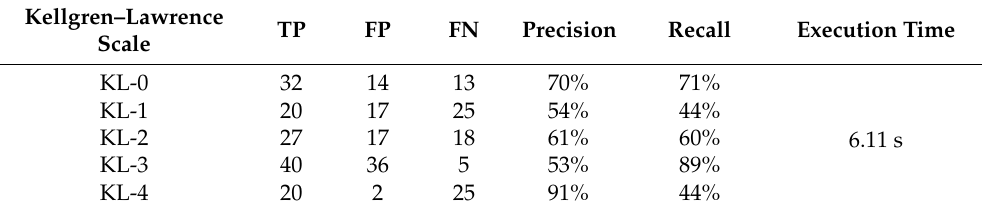
Figure 4. Confusion matrix for KL grading according to the proposed model.